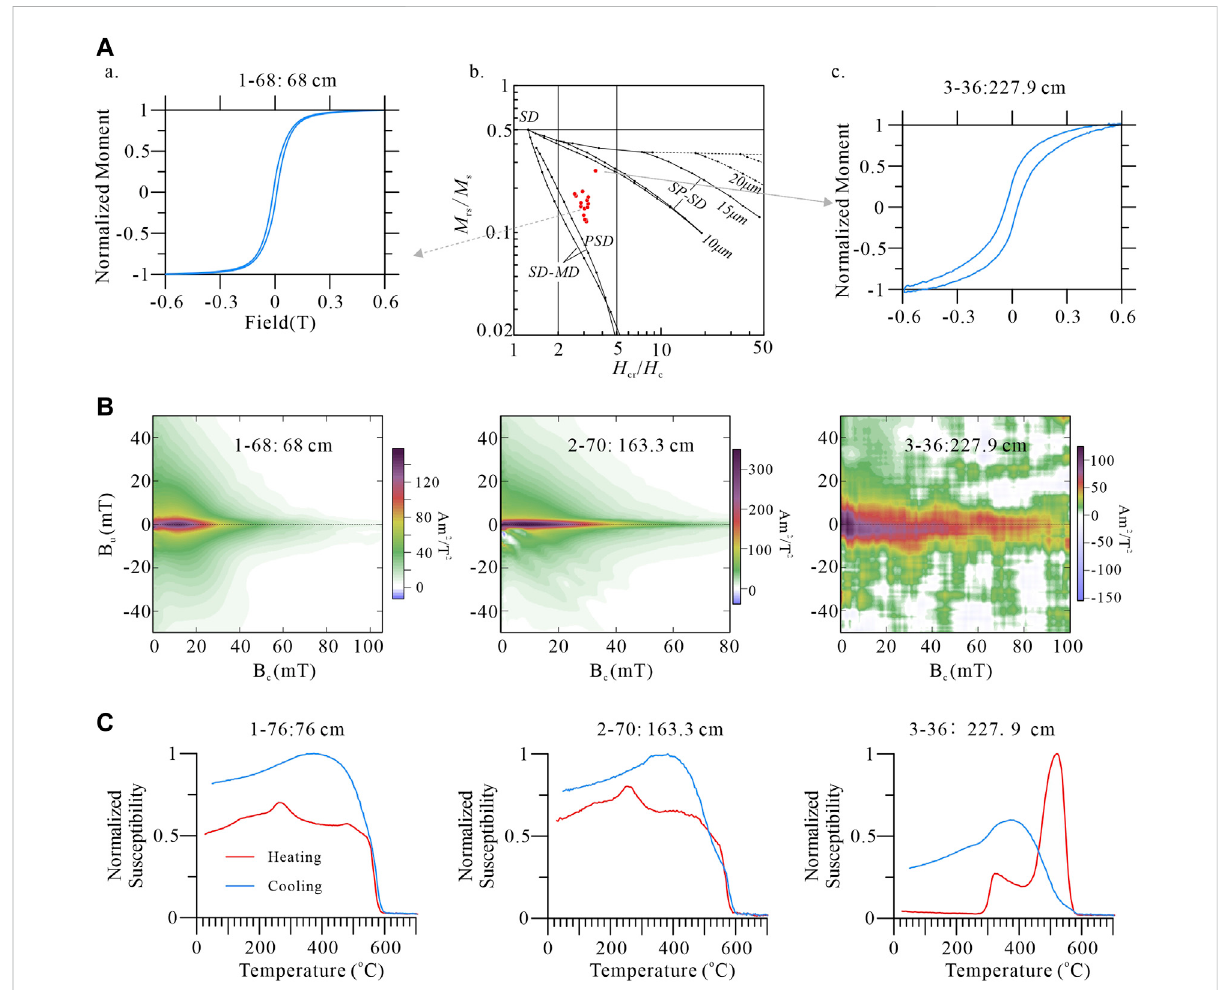
FIGURE 2 Hysteresis loops and Day-plot project following Dunlop (2002) for the representative samples (A) ; FORC diagram processed using FORCinel software (Egli, 2013) and temperature dependence of magnetic susceptibility variation are displayed in (B) and (C) , respectively. In (A) , SD = single domain; PSD = pseudosingle domain and MD = multidomain. (C) FORC diagrams of several typical